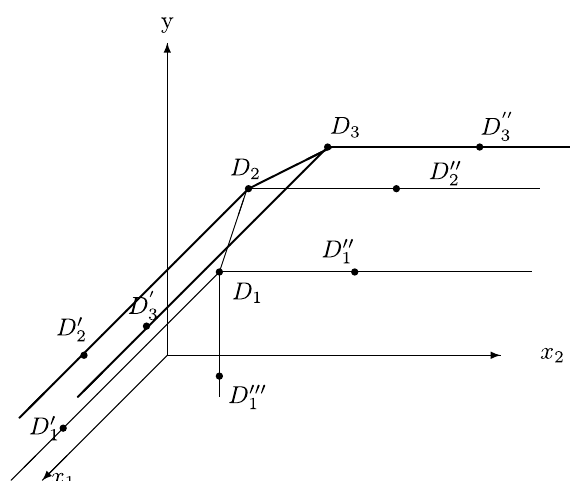
Fig. 2 Weak efficient virtual and anchor